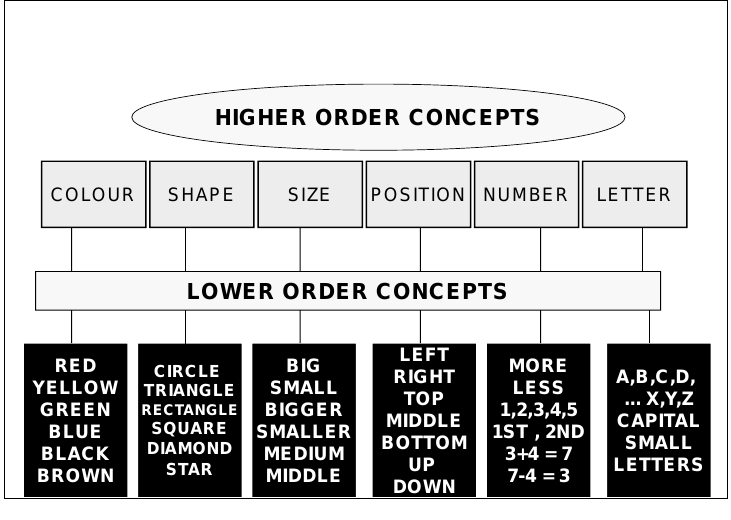
Figure 1 Content of the BCMLP